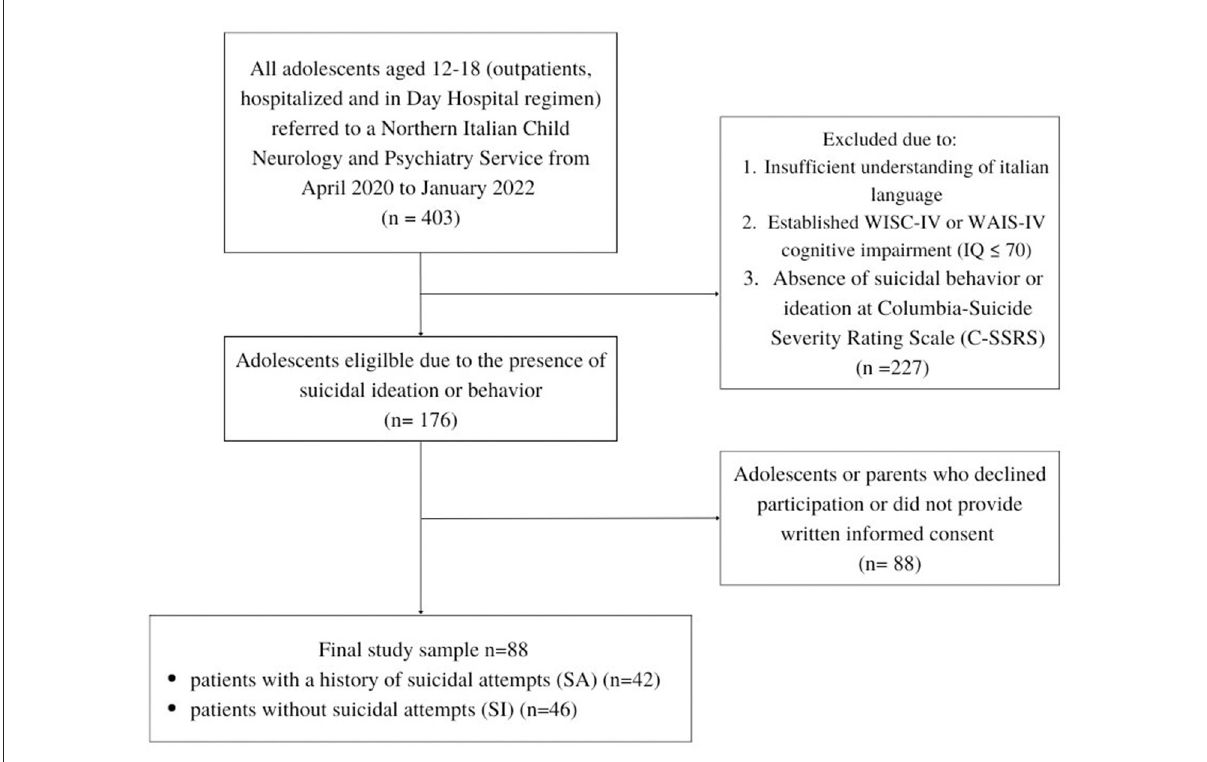
FIGURE1 Study sample